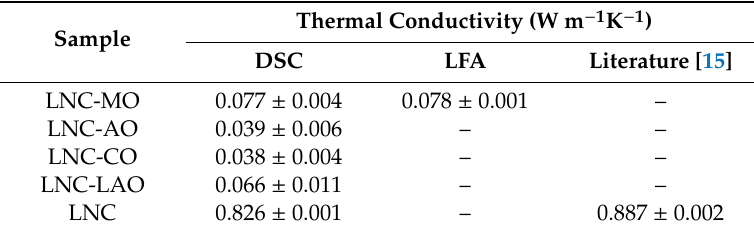
Table 3. The estimated thermal conductivity of the samples.